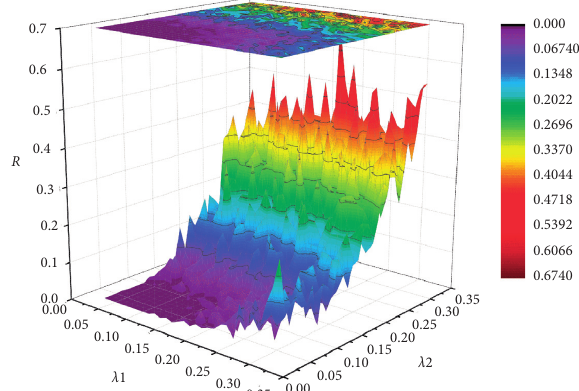
Figure 11: Density of R with λ f ( m ) � 0 . 5 η � 0 . 1, c